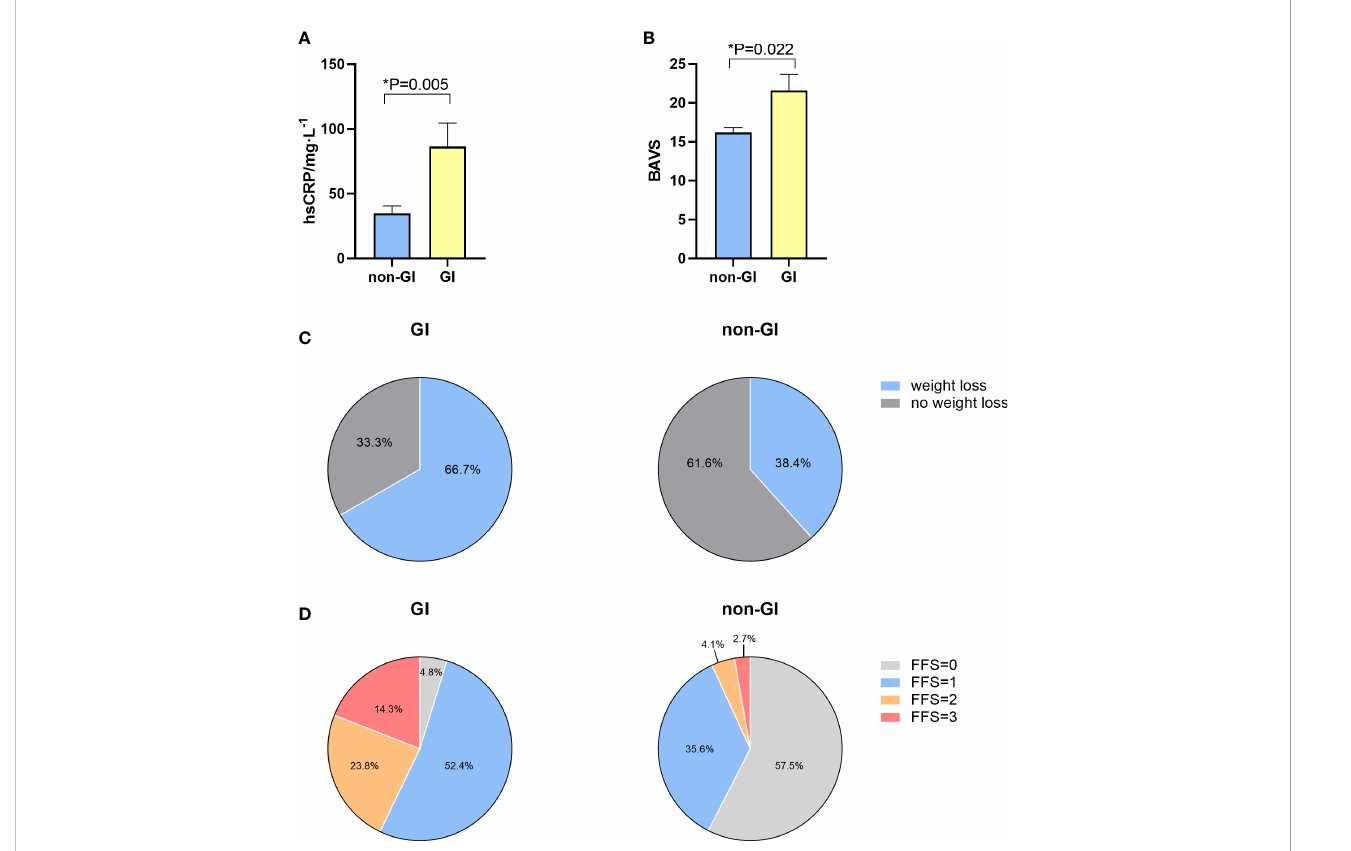
FIGURE 1 Distinct characteristics between EGPA patients with and without GI